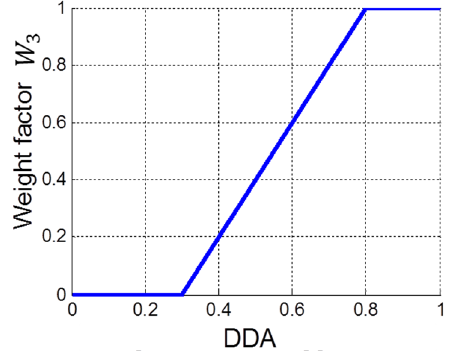
Figure 16. Weight factor for battery charging